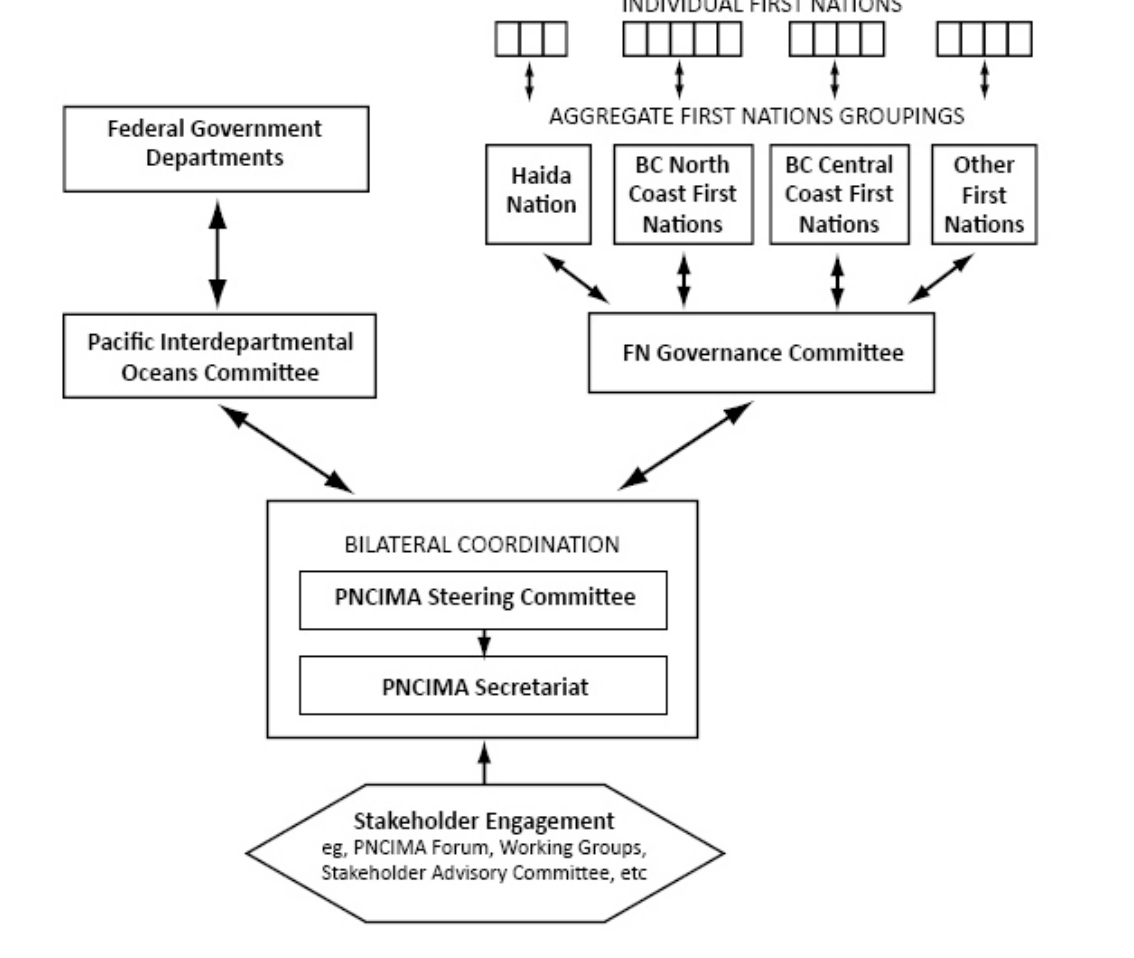
Fig. 3 . Governance model for Pacific North Coast Integrated Management Area (PNCIMA)